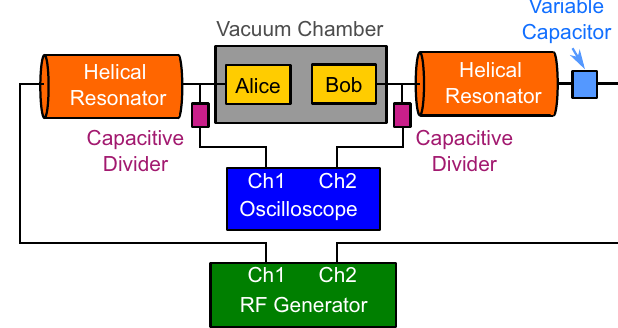
Fig. 6 | Diagram of the RF delivery system for the Alice and Bob trap modules. Each of the modules uses a separate RF source which is ampli fi ed and impedance matched to the ion traps using a helical resonator. A capacitive divider is used to measure the RF amplitude and phase applied to each trap on an oscilloscope.